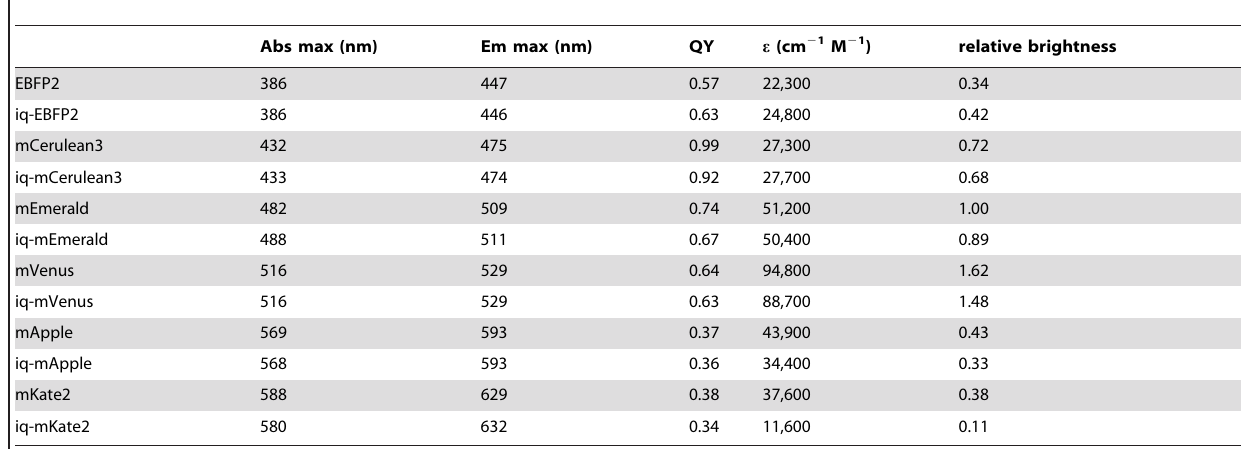
Table 1. The absorption, emission, quantum yield, distinctive coefficient, and relative brightness values of all the FPs and